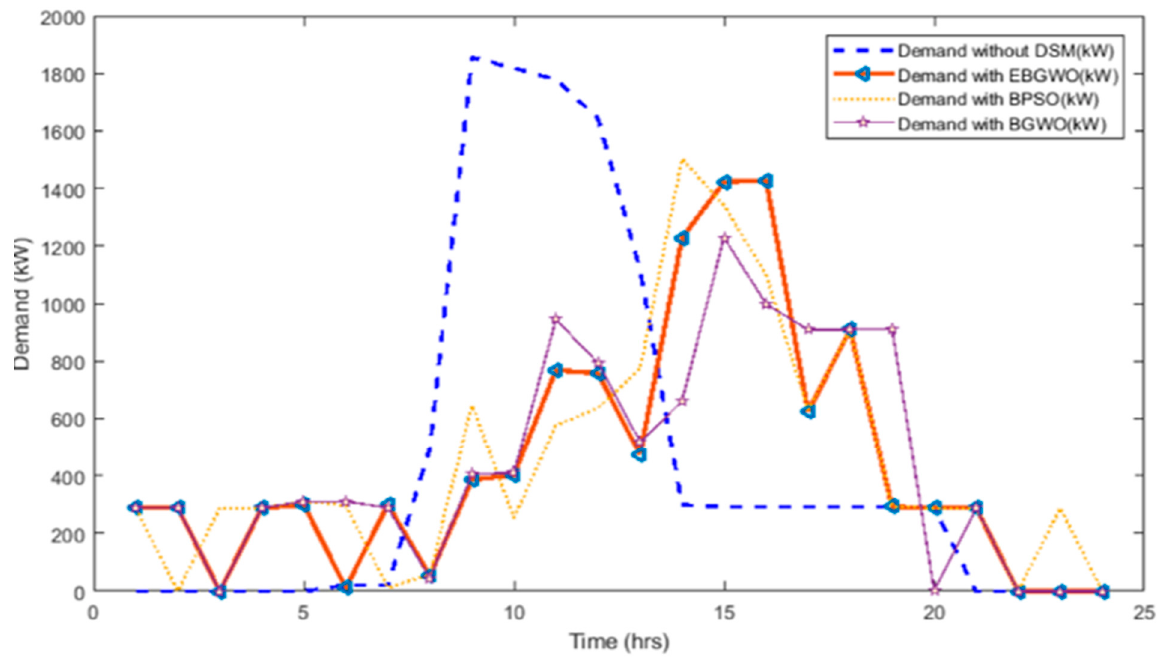
Figure 6. Demand before and after DSM with various optimization algorithms.